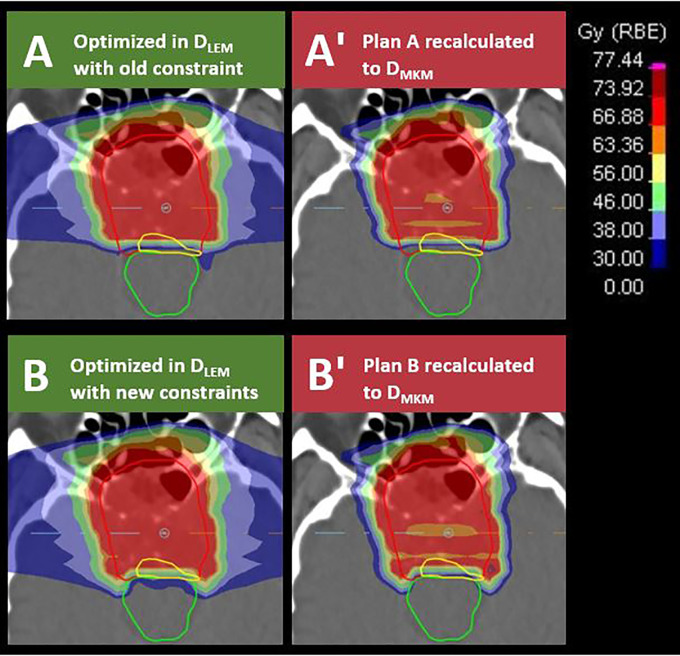
Transversal sections of D
LEM I-optimized treatment plans applying brainstem (green contour) constraints of D
LEM I|1% <30 Gy (RBE) in plan (A) or D
LEM I|0.7 cm3 <38 Gy (RBE) and D
LEM|0.1 cm3 <46 Gy (RBE) in plan B). The dose constraint levels are illustrated by dark blue, light blue, and light green isodose, respectively. Plans were subsequently recalculated to D
MKM
(A′, B′). Red isodose in plan (A, B) represents 95% of the target dose (70.4 Gy (RBE) in D
LEM I). Note the improved dose coverage to the CTV (red contour) and to the part of the CTV in which the tumor recurred (yellow contour) in plan B compared with plan A. Dose to the brainstem remains compliant with the constraints defined by Shirai et al. when evaluated in D
MKM
(B′).